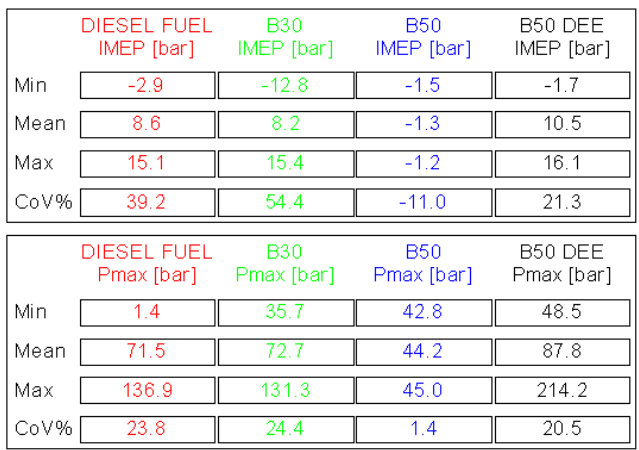
Energies 2016 , 9 , 284